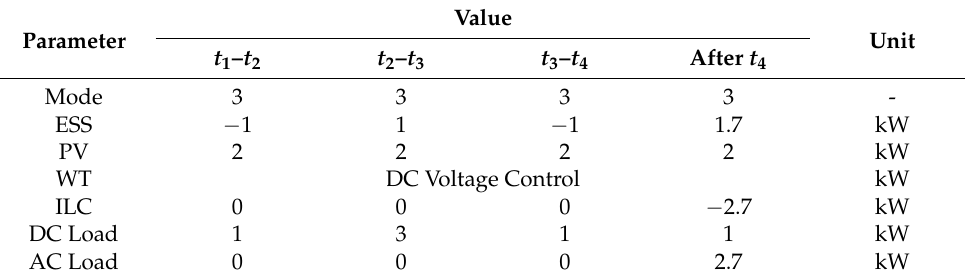
Table 5. Microgrid power flow (1) during standalone operation.